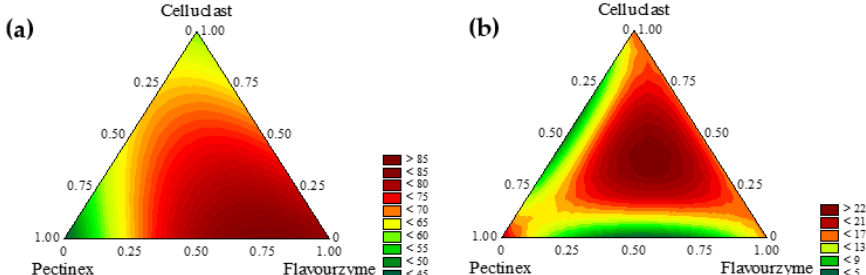
Figure 2. Contour plots for antioxidant activity evaluated by ABTS ( a ) and DPPH ( b ) methods, re- spectively, for banana bract extracts (Prata